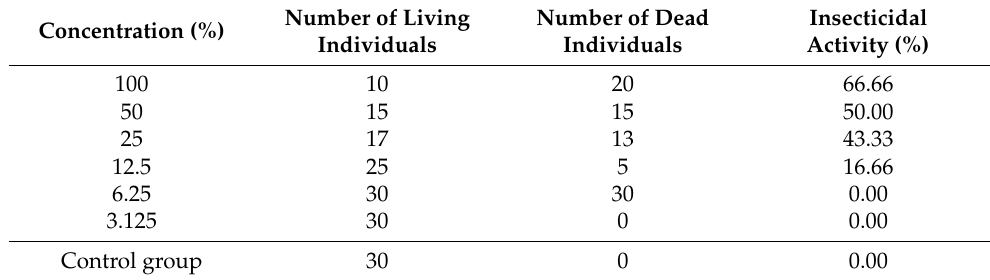
Table 8. Insecticidal activity of SSEO.